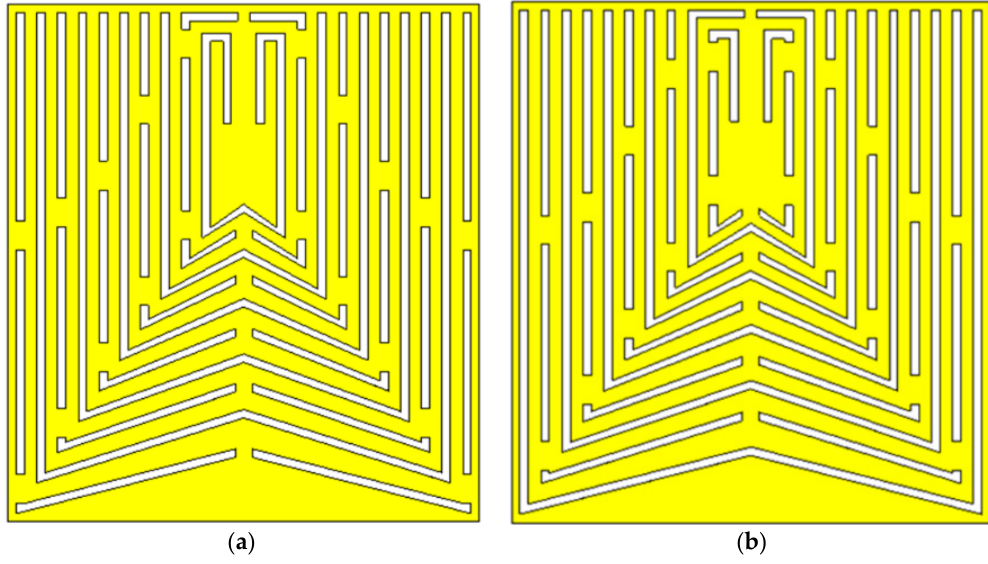
Figure 4. Designed tag with two different bit combinations: ( a ) “0101010101” and ( b ) “1010101010”.